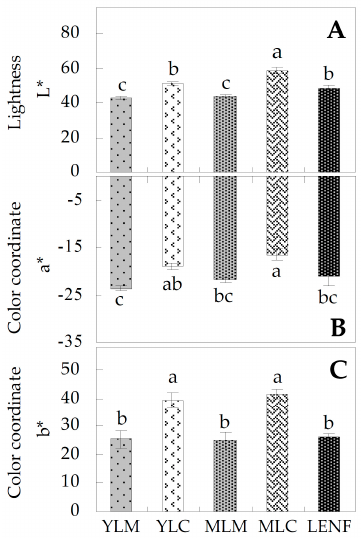
Figure 2. Color properties of various leaf regions at different development stages of Hosta “Gold Standard”. ( A ) Lightness L*, representing the perceived lightness; ( B ) color coordinate a*, indicating the change in hue from red to green; ( C ) color coordinate b*, indicating the change in hue from yellow to blue. The values were determined in young leaf margin (YLM), young leaf center (YLC), mature leaf margin (MLM), mature leaf center (MLC), and leaf under excess nitrogen fertilization (LENF), which were presented as means ± SE ( n = 3). The different small letters on the columns indicate significant differences among various leaf regions at different development stages ( p < 0.05).